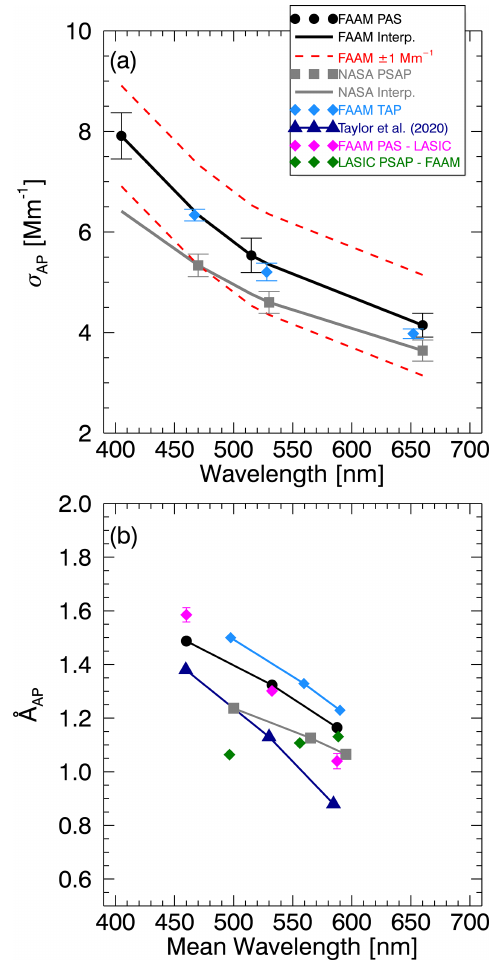
Figure 9. Optical absorption coefficient as a function of wavelength for boundary layer leg runBL_2 (Table 2). Observations are shown as mean (symbols) and standard deviation (error bars) for FAAM EXSCALABAR PAS and NASA PSAP data, along with FAAM TAP data. Interpolated values of σ AP are shown, which use Å AP from observations for FAAM and NASA. (b) Å AP as a function of pairs of mean wavelengths for runBL_1 and the weighted mean of observations from four FAAM fly-pasts of the LASIC ARM site are shown (17, 18, 22 and 24 August). Full CLARIFY campaign data are reproduced from Taylor et al.